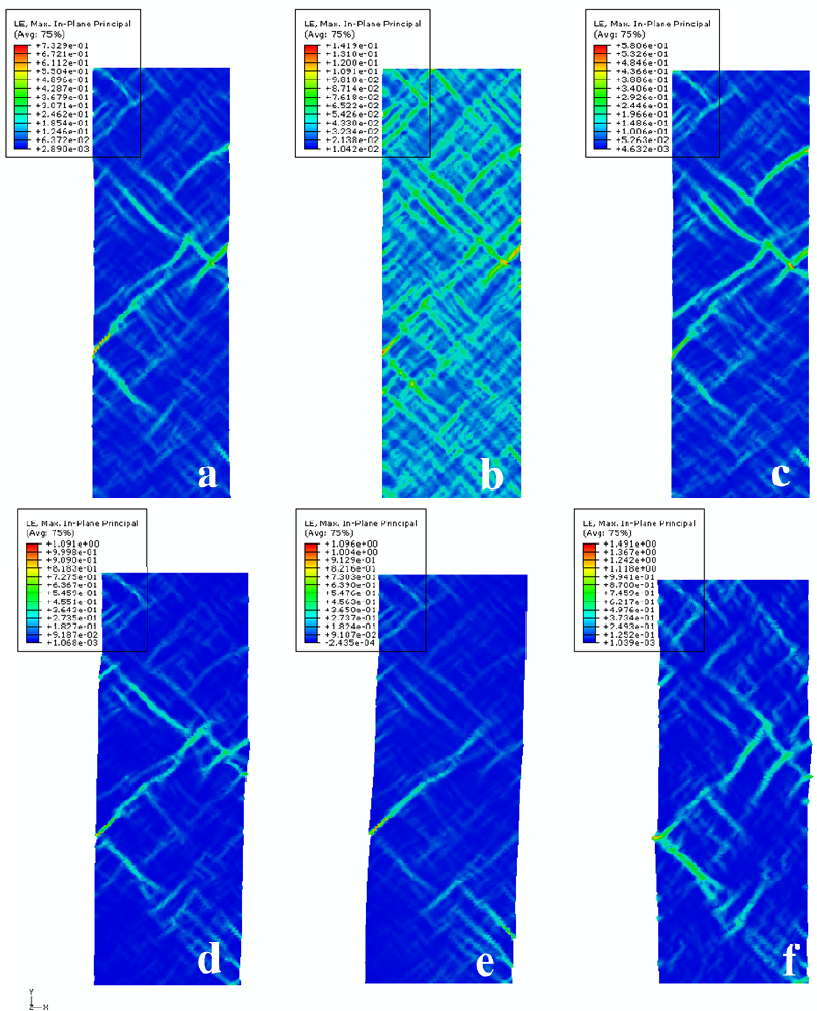
Figure 6. Shear band formation under plane strain tension by ( a ) J ( c ) DP model ( a = 0.045), and under plane strain compression by ( d ) J ( f ) DP model( a =